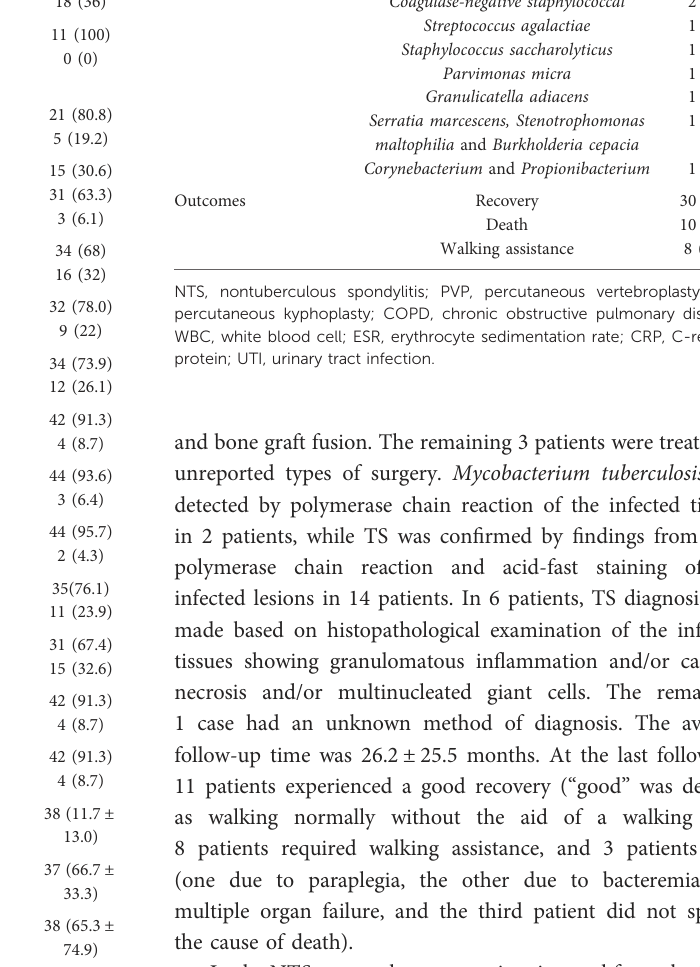
made based on histopathological examination of the infected tissues showing granulomatous in fl ammation and/or caseous 1 case had an unknown method of diagnosis. The average